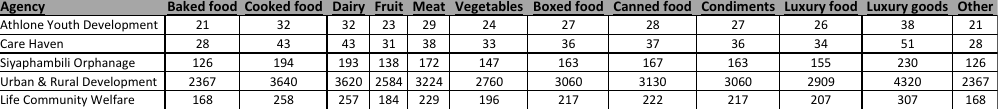
Figure 4: An example of the allocation values in the Excel spreadsheet of